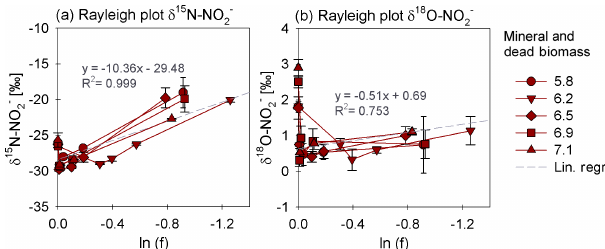
δ 15 N (a) and δ 18 O (b) values Figure 5. Rayleigh plots for NO − 2 measured for the mineral and dead biomass amended set-ups over the natural logarithm (ln) of the substrate fraction remaining at dif- ferent pH levels. The average linear regression line was calculated starting with the lowest delta values (after the initial decrease in both δ 15 N and δ 18 O during the initial experimental phase). The equa- tions and R 2 values are given in grey. The standard error calculated from biological replicates ( n = 3) is represented by the error bars.